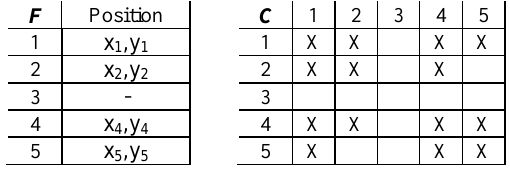
Table 1: Exemplary information associated with one